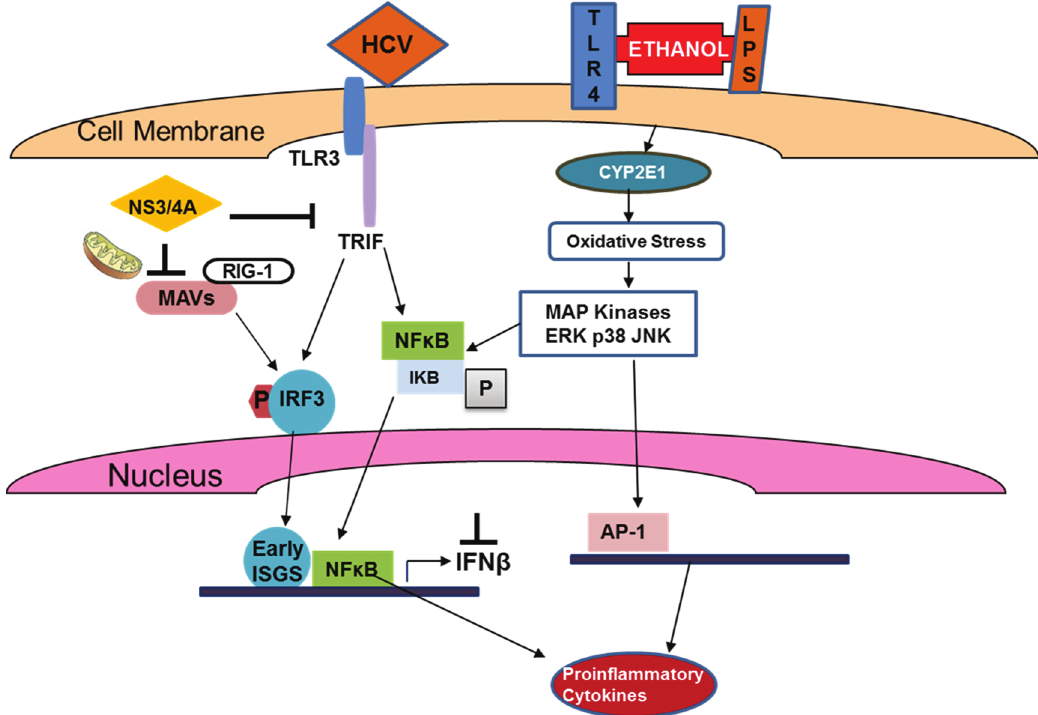
Figure 4. Effects of HCV and ethanol on activation of early ISGs and genes responsible for production of pro-inflammatory